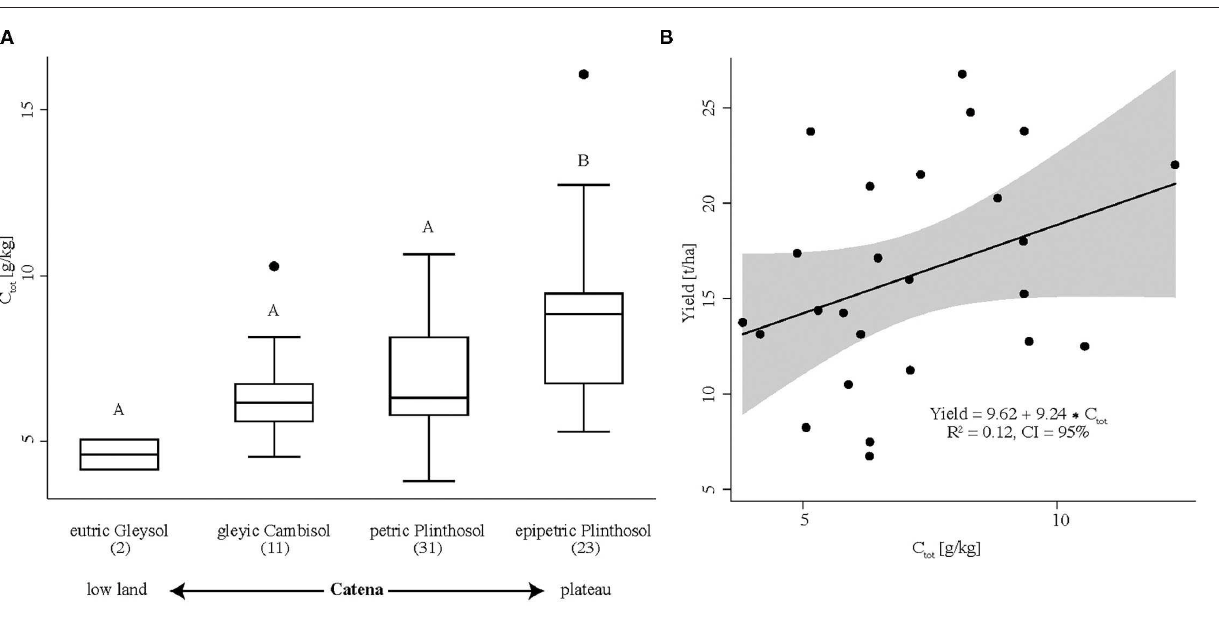
FIGURE 2 | (A) Top soil (0–30cm) carbon of yam fields grouped by soil type according to the soil map of Sib and Sinkondo (2002). The letters (A, B) indicate the Tukey groups of a pairwise comparison of the means (level of significance: 5%). (B) Yam yield vs. top soil (0–30cm) organic carbon. The gray area indicates the 95% confidence interval of the linear regression.